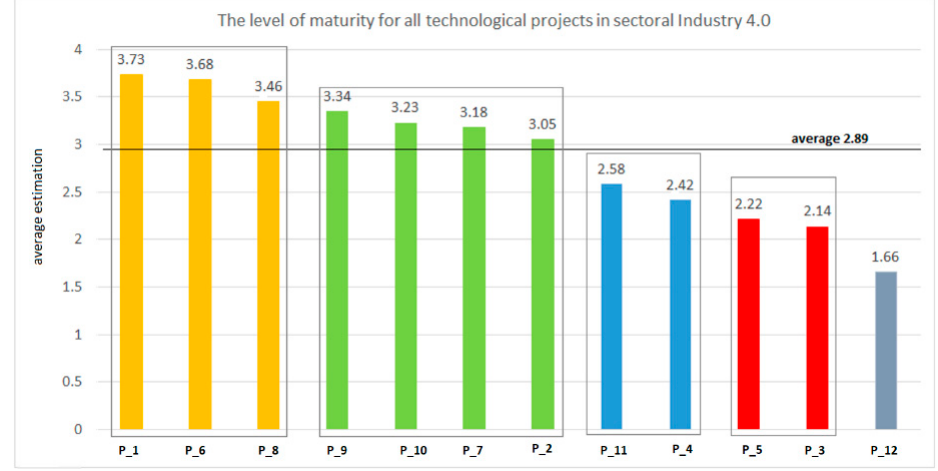
Figure 3. The levels of maturity based on realised projects in the studied steel sector. Source: own research for N = 79 [123].